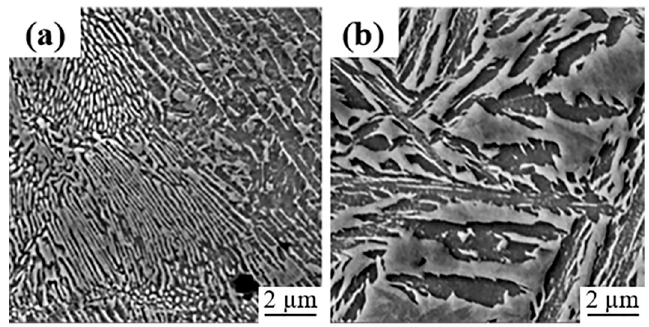
Figure 7. Microstructure, ( a ) DI: Pearlite, ( b ) ADI: